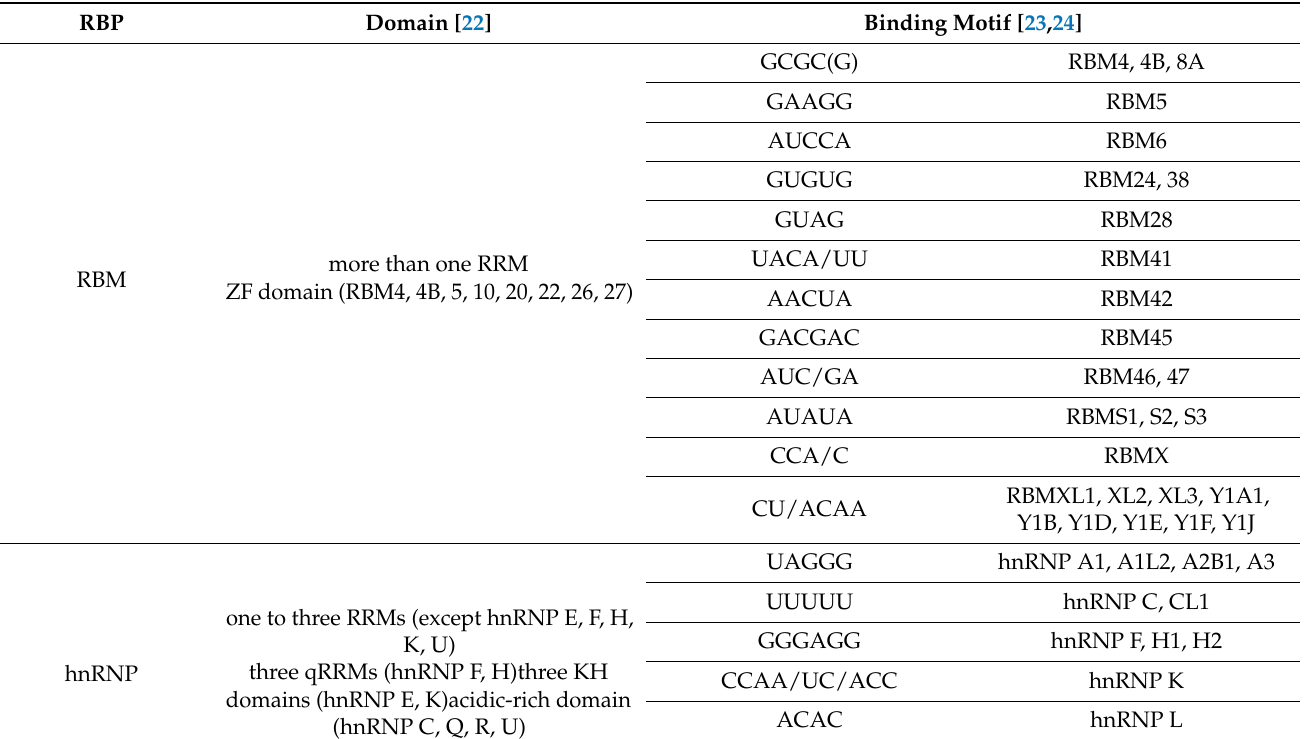
Table 1. List of domains and estimated binding motifs of RBPs based on the protein database.